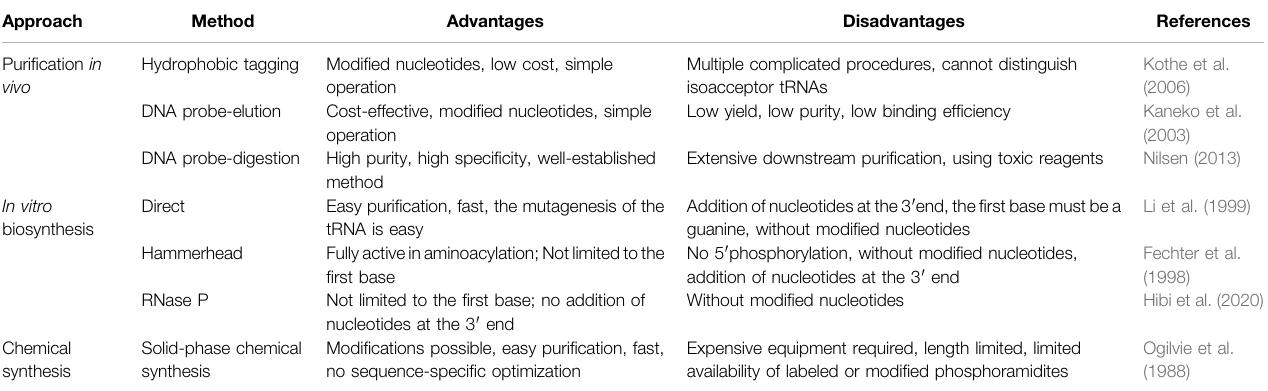
TABLE 1 | Advantages and disadvantages of different tRNA production